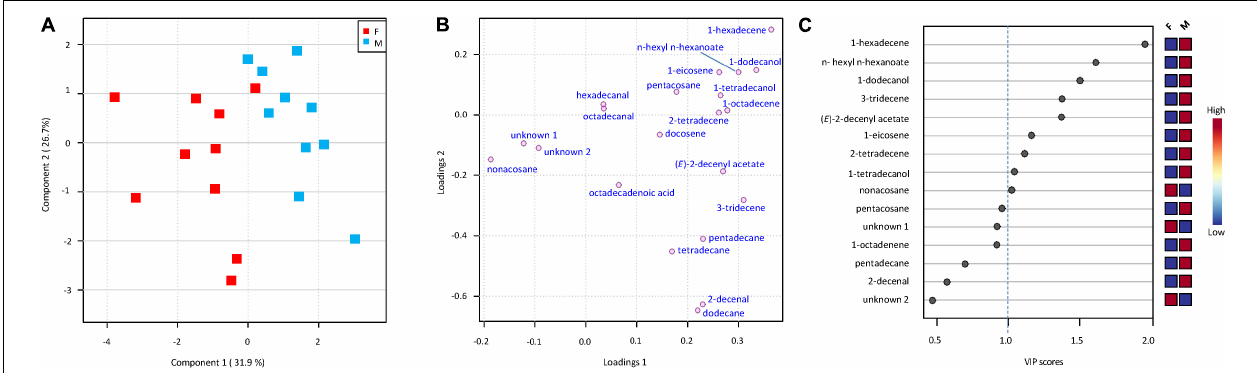
FIGURE 4 | Projection to latent structures discriminant analysis (PLS-DA) of cuticular compounds extracted from Halyomorpha halys females (F) and males (M). (A) Score plot visualizing the grouping pattern of the samples according to the first two principal components (PCs) with the explained variance in parenthesis. The PLS-DA resulted in a model with a significant component ( R 2 X = 0.319, R 2 Y = 0.628, Q 2 = 0.470), but only the first two PCs are shown for representational purposes. (B) Loading plot of the first two PCs shows the contribution of each compound to the two PLS-DA components. (C) Compounds ranked according to values of Variable Important for the Projection (VIP). Compounds with VIP value < 0.5 are not shown. Red squares indicate higher relative amounts between males and females, blue squares indicate lower relative